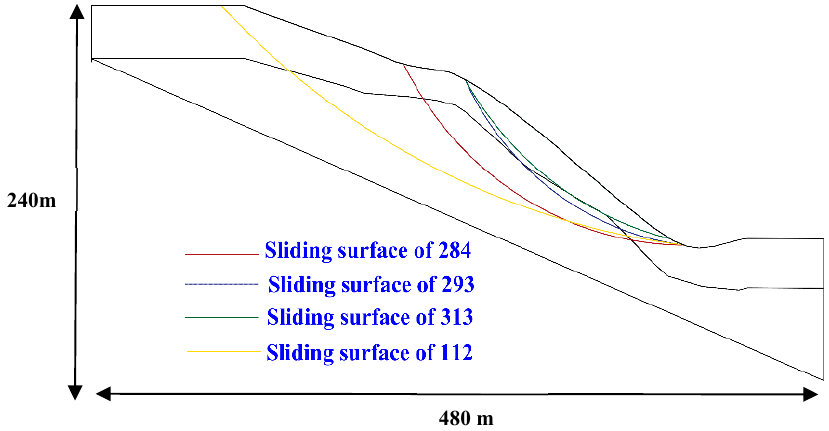
Figure 13. Locations of the sliding surfaces.